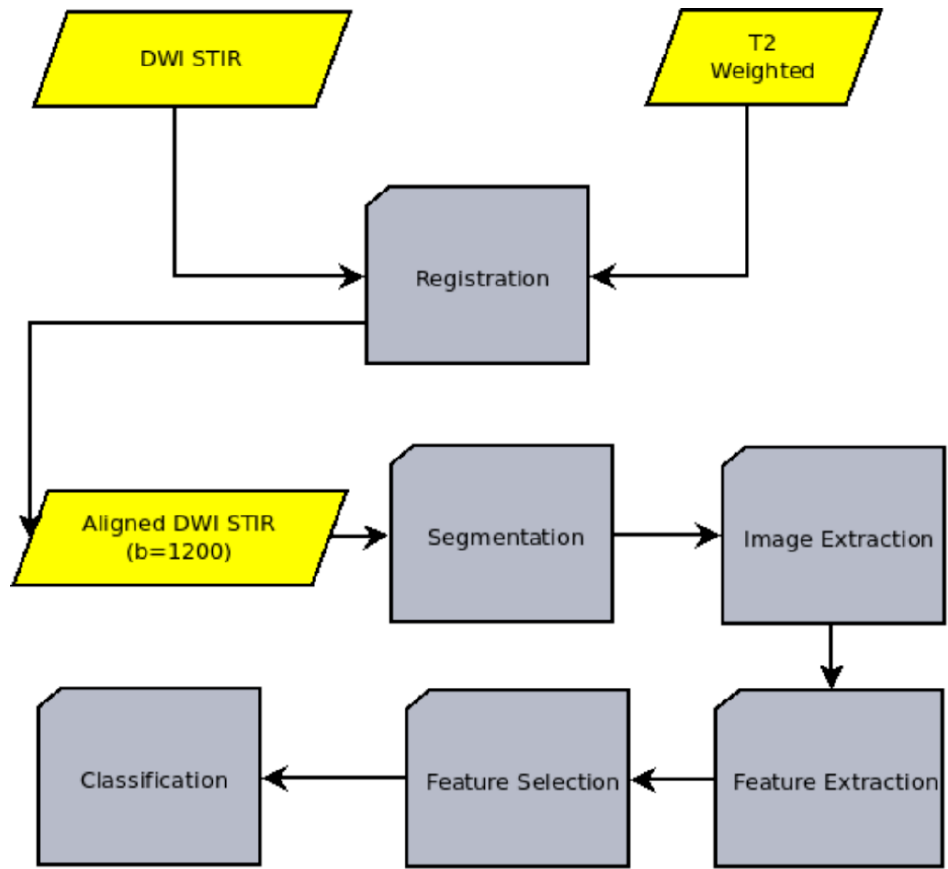
Figure 1. Flow Diagram of the Proposed System.